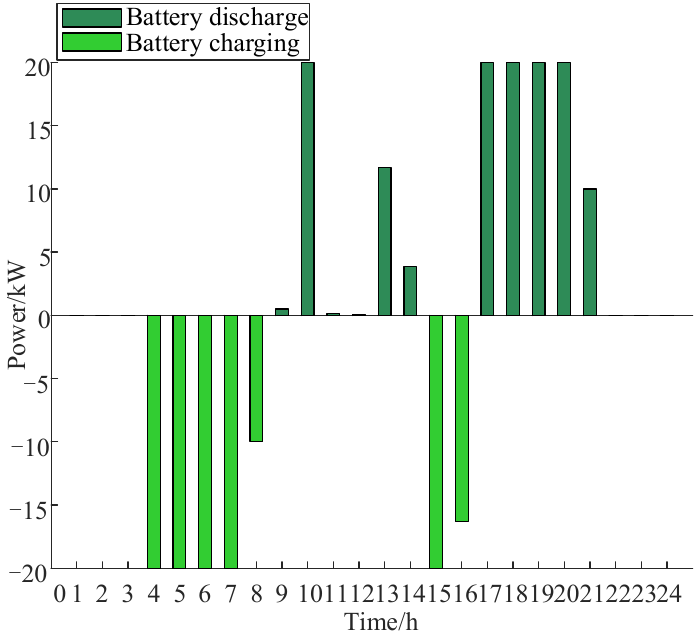
Figure 9. Matching and discharging optimization of battery life attenuation battery.